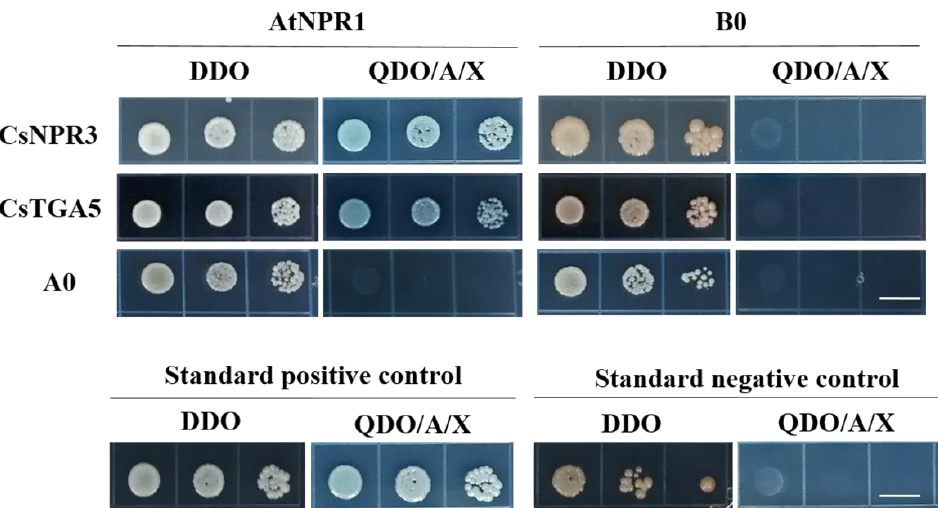
Figure 6. Yeast-two-hybrid (Y2H) interaction assays of AtNPR1 with CsNPR3 and CsTGA5. DDO (double dropout medium): SD/-Trp and -Leu, QDO (quadruple dropout medium)/X/A: SD/-Leu/-Trp/-Ade/-His + X-α-Gal and Aureobasidin A. The empty BD (B0) and AD (A0) vectors were used as negative controls. Standard positive control (pGBKT7-53 and pGADT7-T; Clontech) and standard negative control (pGBKT7-Lam and pGADT7-T) were included. The scale bar at the bottom of the figure denotes 1 cm length.